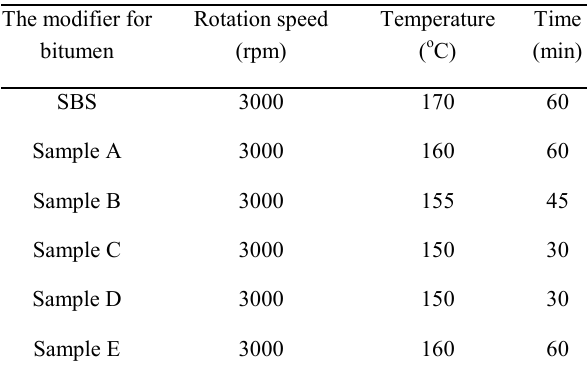
Table 3. Composition of the blends prepared in the extruder. The modifier for